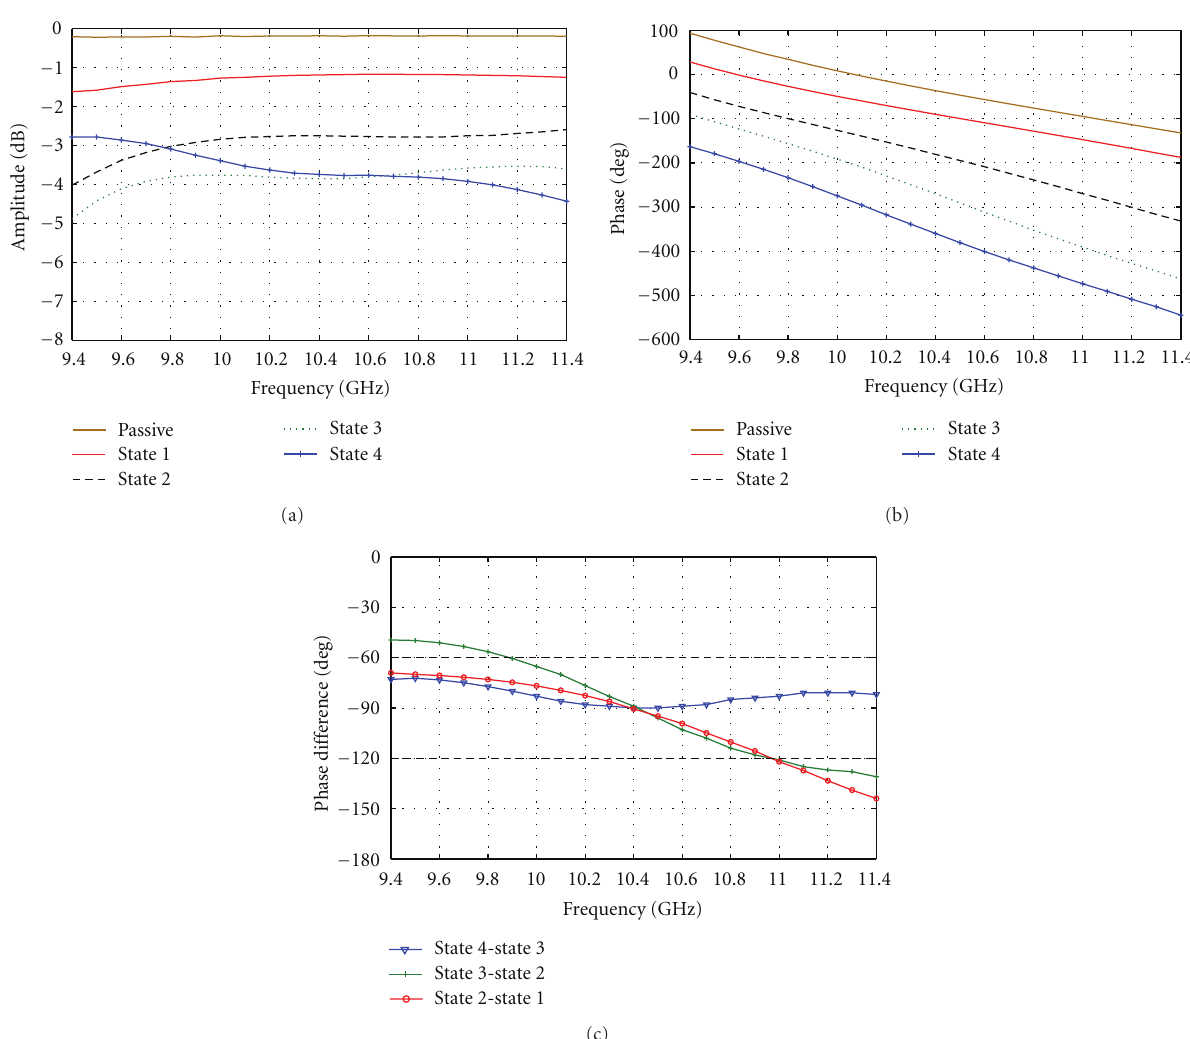
Figure 13: Reflection coe ffi cient for the 2-bit wideband element with two stacked patches in a periodic environment. (a) Amplitude. (b) Phase. (c) Phase di ff erence between the adjacent